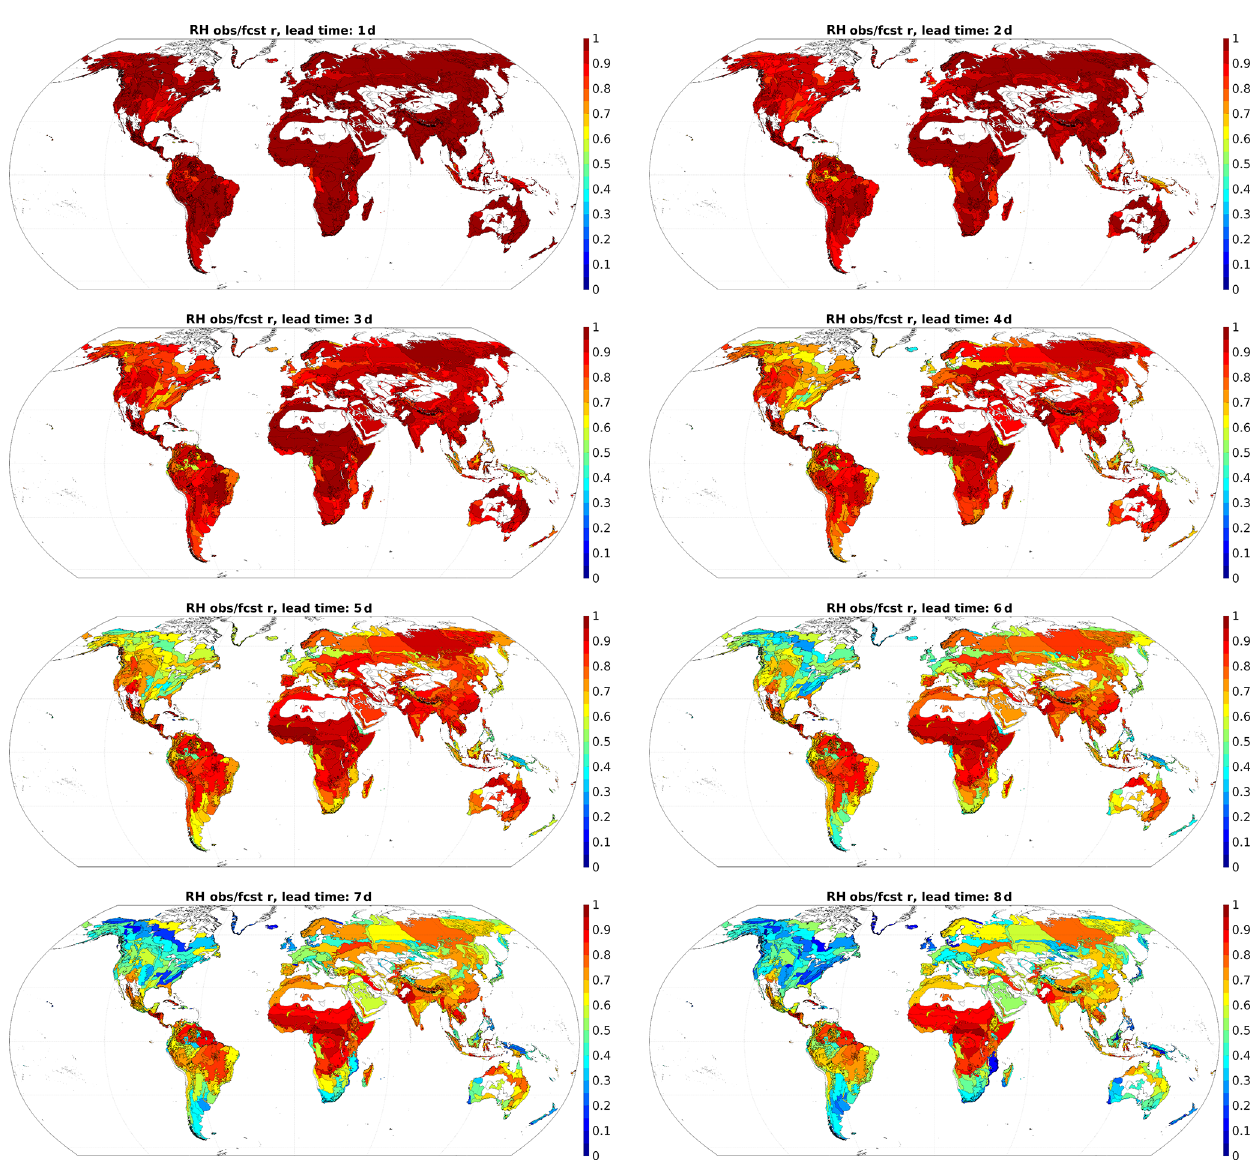
Figure 16. Same as Fig. 11 but for relative humidity